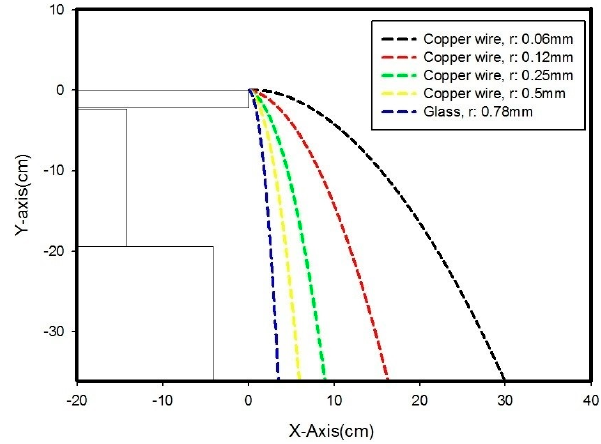
Figure 8. Trajectory simulation by particle size for copper wires and glass. (Applied voltage (U): 20 kV initial speed (v 0 ): 0.13 m · s − 1 , distance between two electrodes (L): 0.6 m).